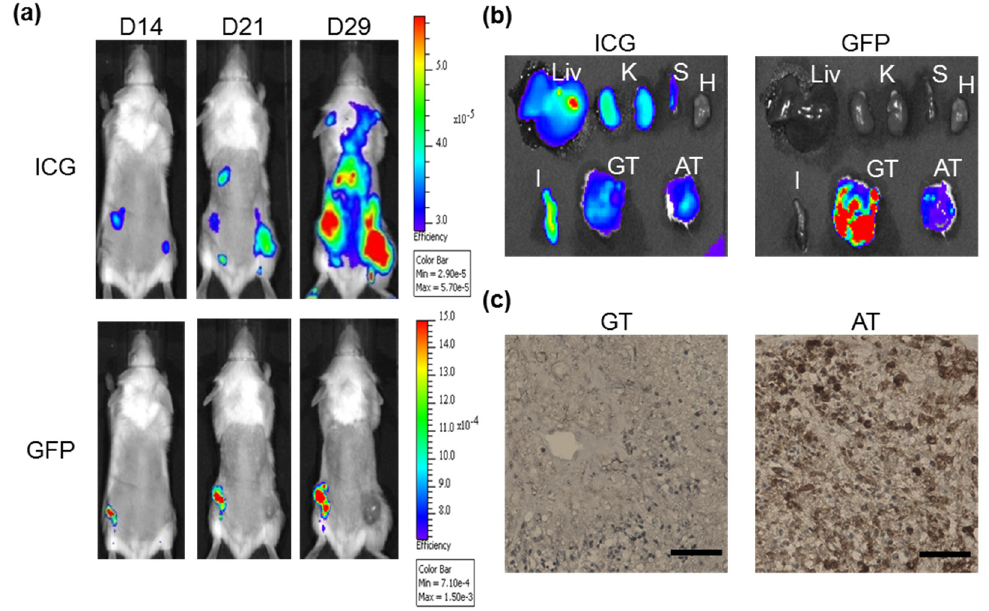
Figure 6. IVIS-based cell tracking with a combination of ICG and ASBT. ( a ) ICG and GFP signal were monitored at Day 14, 21, and 29 after xenografting. ( b ) The biodistribution of ICG and GFP. ( c ) ASBT expression identified by IHC. Liv: liver. K: kidney. S: spleen. H: heart. I: small intestine. GT: GFP-expressing tumor. AT: ASBT-expressing tumor. Scale bar: 160 μ m.